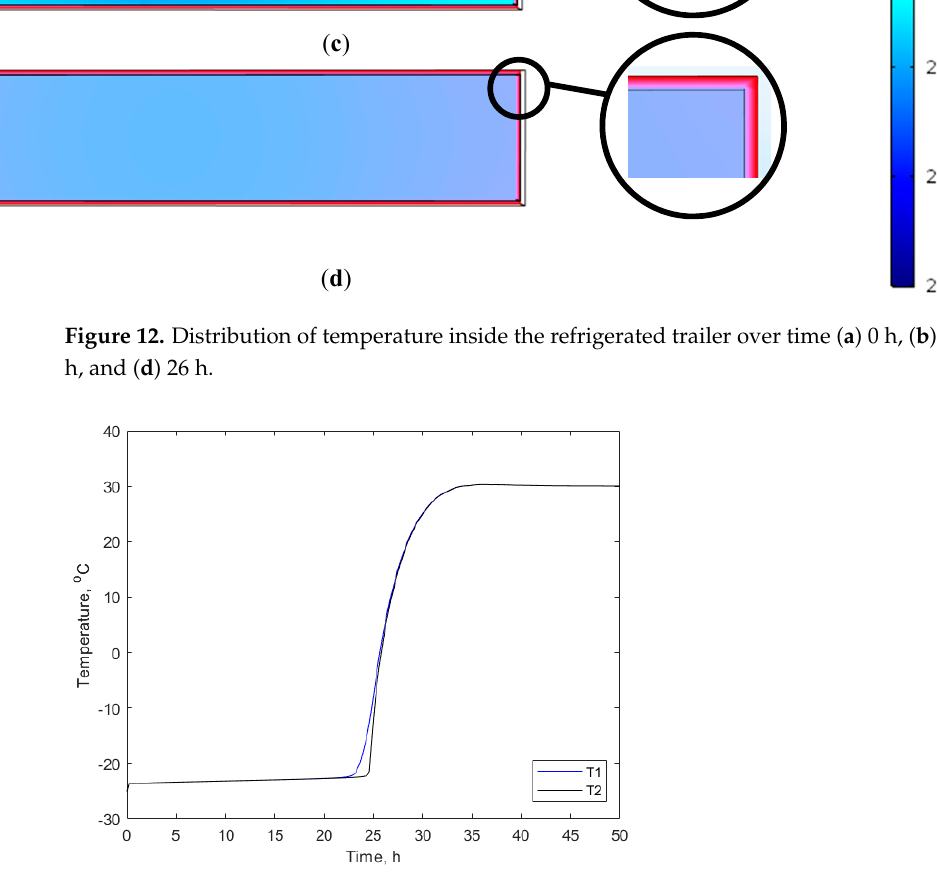
Figure 13. Graph of numerical results of temperature changes inside the refrigerated trailer at T1 and T2.